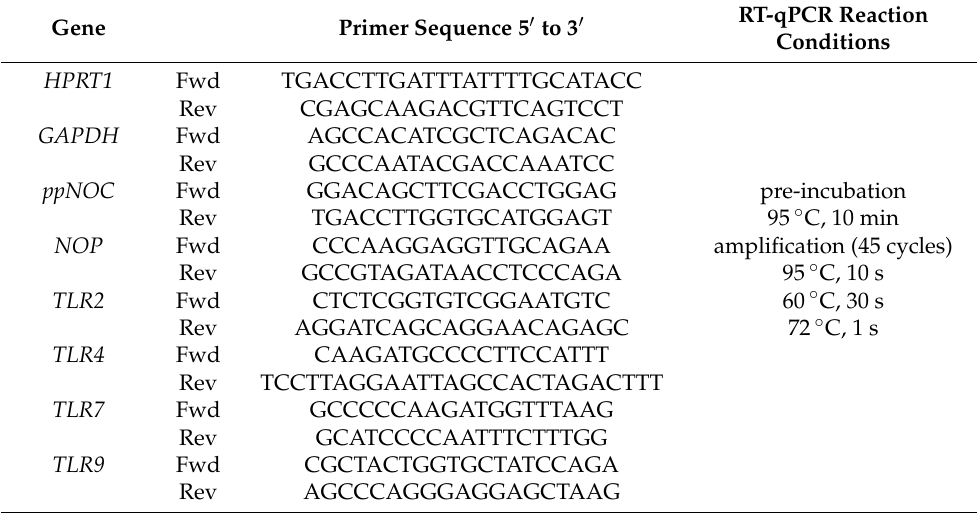
Table 1. Sequence of primers and RT-qPCR reaction